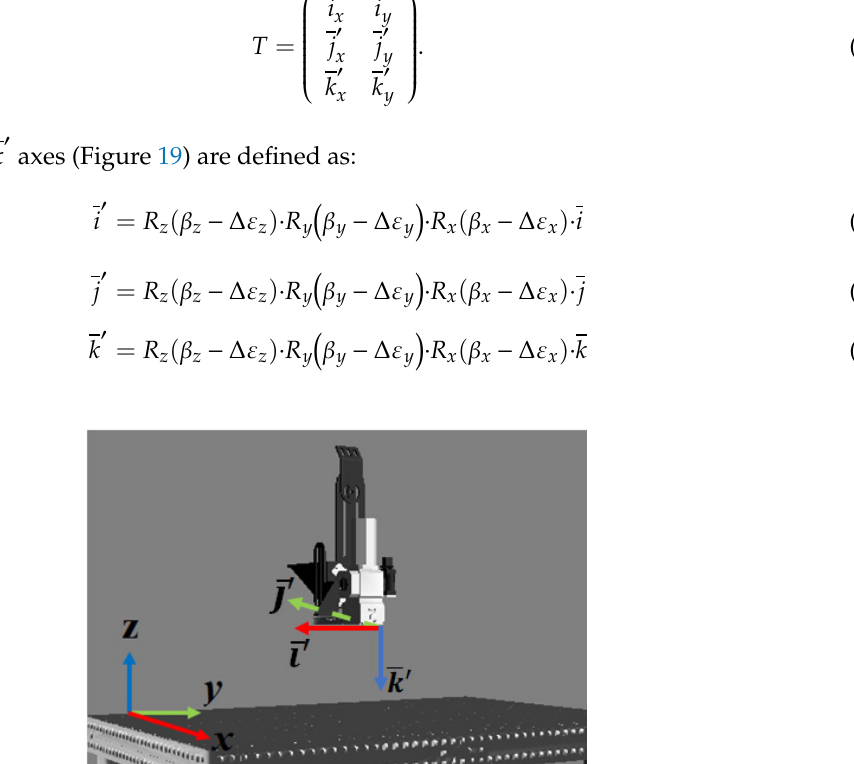
Figure 19. Location of the image base {𝚤̅ (cid:4593) ,𝚥̅ (cid:4593) , 𝑘(cid:3364) (cid:4593) } relative to the base of the LRC-W workspace.